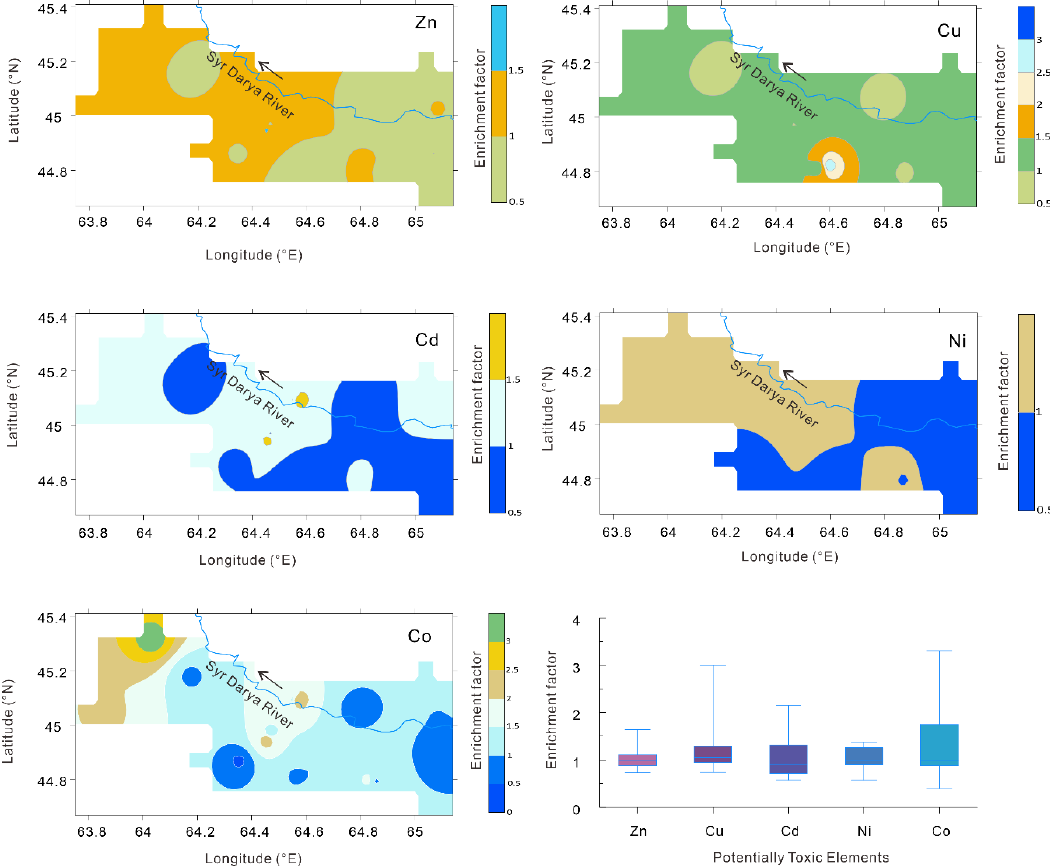
Figure 5. Basic statistical chart and spatial distribution maps of the enrichment coefficients of the potentially toxic elements in sampling region II.